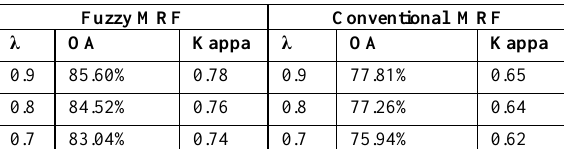
Table 3. Kappa and OA, agreement between the Optimal